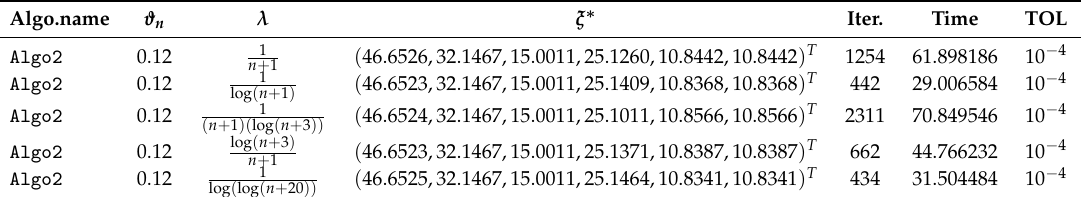
Figure 3 and Table 5 describe the numerical results for error term D n = (cid:107) u n + 1 − u n (cid:107) ≤ TOL for Algorithm 2 ( Algo2 ). Table 5. Experiment in Section 6.1.3: Algorithm 2 numerical values by using different step-size sequences λ n